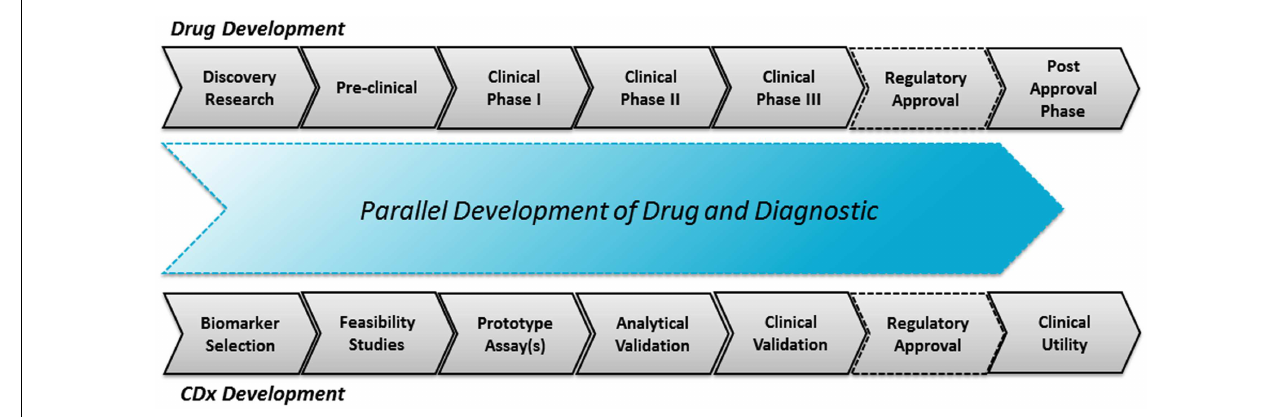
FIGURE 1 |The drug–diagnostic co-development model .The upper parts illustrate the drug development process and the lower parts the parallel CDx development process with an aligned regulatory co-approval at the end of phase